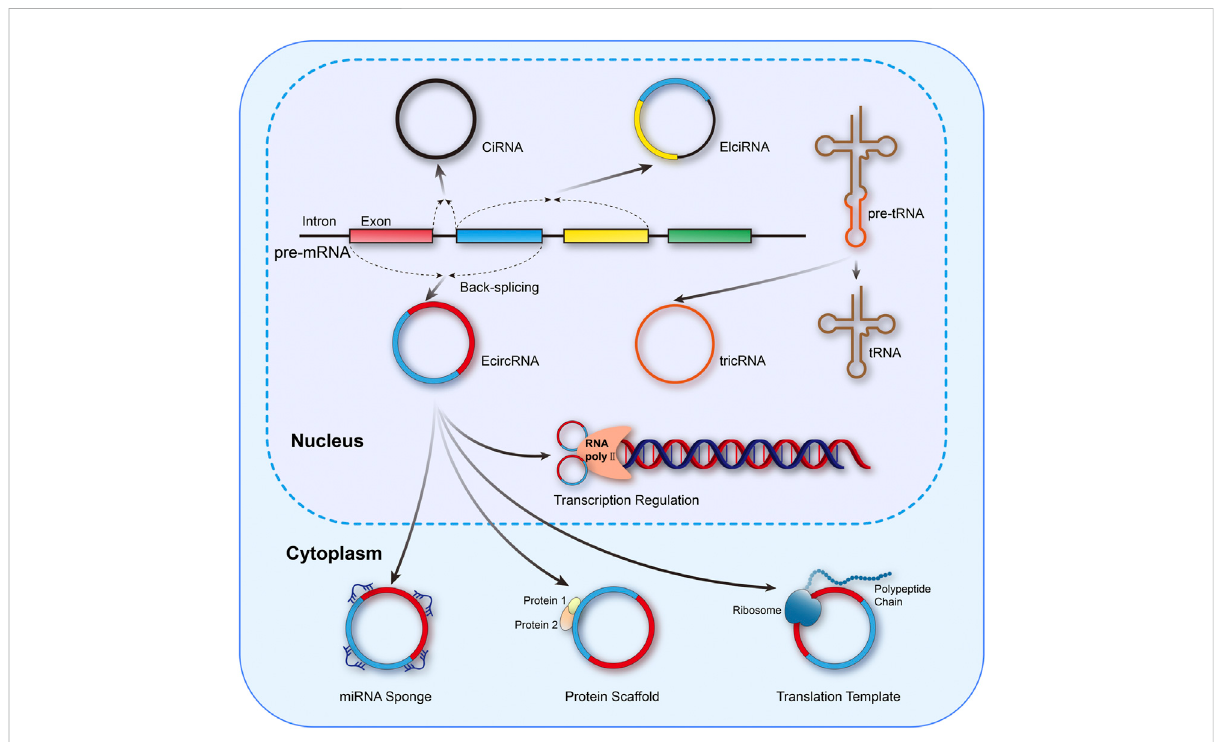
FIGURE 1 Mainstream formation and function mechanisms of circRNAs. circRNAs could be classi fi ed as EcircRNAs, EIciRNAs, CiRNAs, and tricRNAs. Meanwhile, the functional mechanisms of circRNAs mainly include miRNA sponges, binding to RNA binding proteins (RBPs), acting as protein scaffolds, regulation of transcription, and templates of translation for